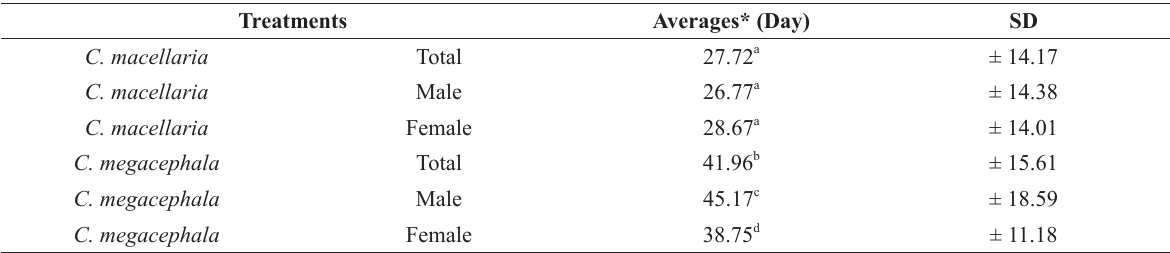
Longevity of Cochliomyia macellaria and Chrysomya megacephala .